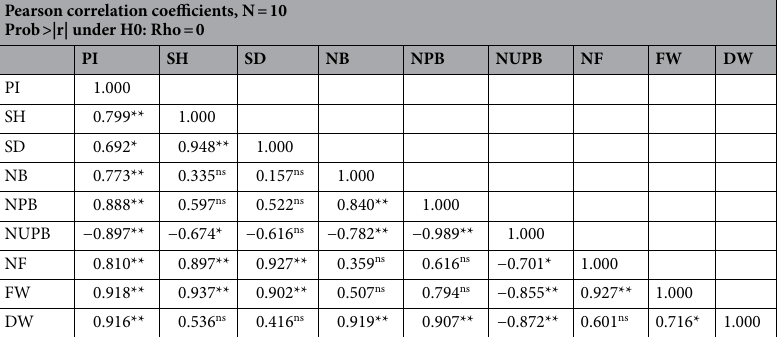
Table 3. Correlation coefficients between primordial initiation and other agro-morphological traits studied. PI primordial initiation, SH stalk height, SD stalk diameter, NB number of branches, NPB number of productive bags, NUPB number of unproductive bags, NF number of flowers, FW fresh weight, DW dry weight. *Significant at P = 0.05, **significant at P = 0.01, ns not